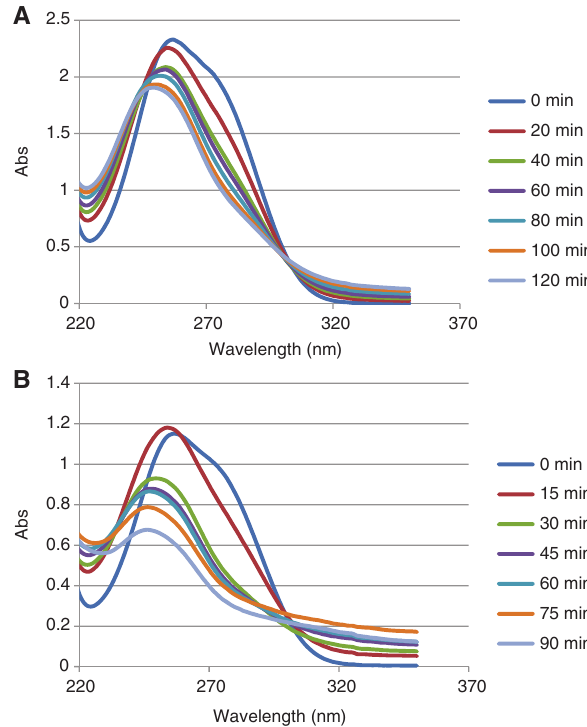
Figure 7: Changes of UV-visible spectra of 30 mgL −1 aqueous solution of STZ in optimum conditions, during the photocatalytic process of UV/CdO with irradiation time of 0–120 and 0–90 min (A) without catalyst and (B) with catalyst, respectively.